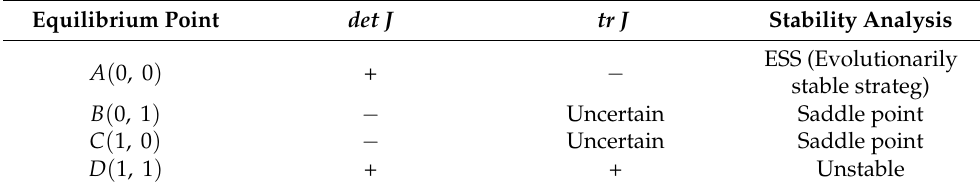
ESS (Evolutionarily stable strateg)